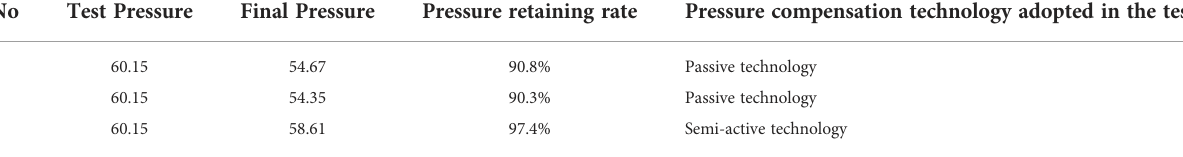
TABLE 2 Pressure retaining data of hyperbaric chamber of PMTI (data from Wang et al., 2022). No